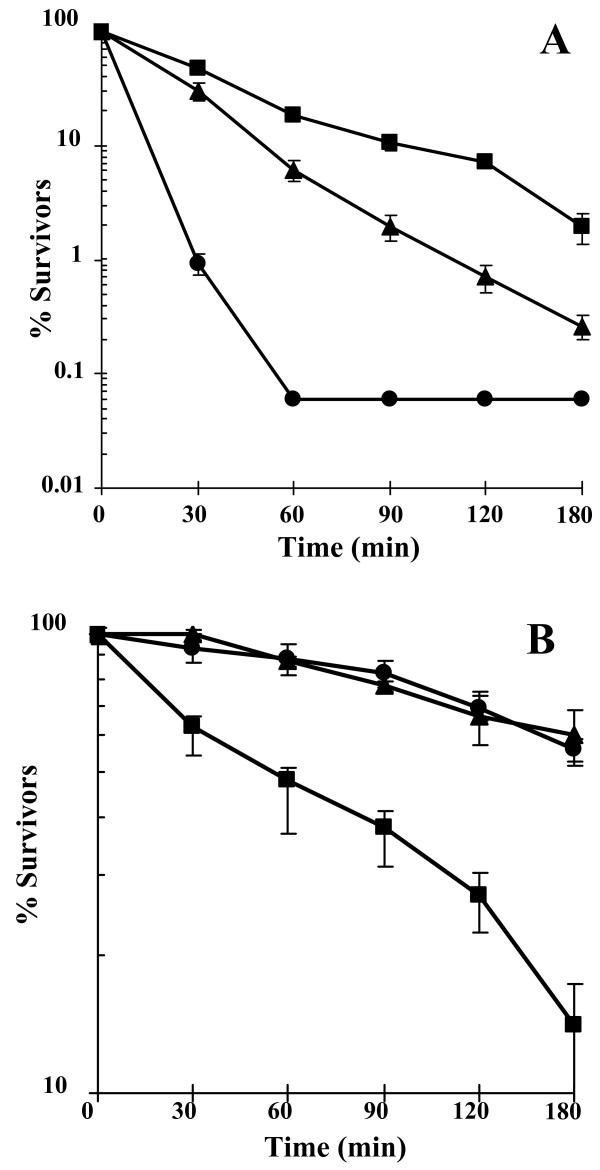
Acid tolerance of E. coli O157:H7 43895 (parent) and hns mutant (FRIK47001P). Survival of the parent strain (●), hns mutant (■), and hns mutant complemented containing pSC0061 (▲) in simulated gastric fluid (pH 1.5) at 37°C when using log-phase (A) and stationary-phase (B) cells. Data points are the average values from at least three trials. Error bars represent the standard error of the mean.